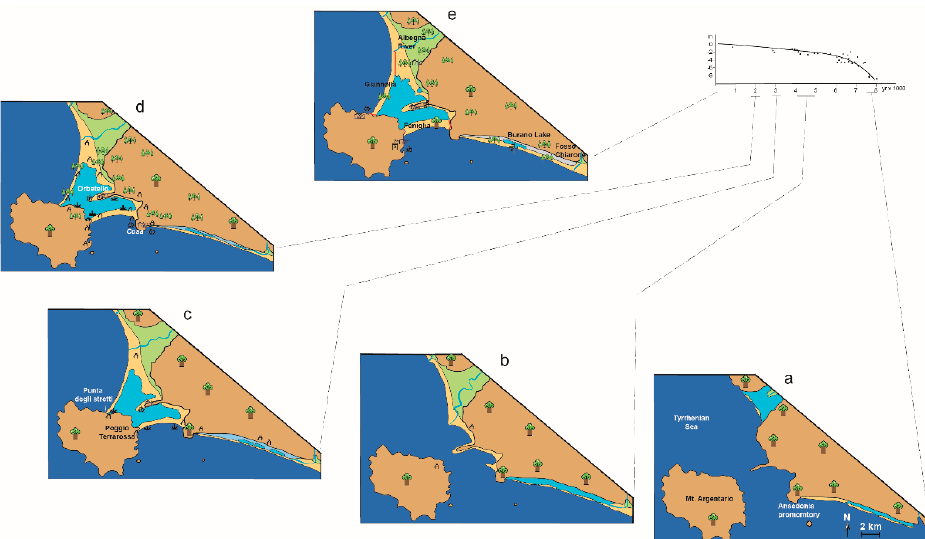
Figure 4. ( a – e ). Two-dimensional evolutionary patterns of the Tuscany area inferred from under- ground and historical/archaeological data. The single images illustrate the coastal landscape relating to the period shown on the abscissae of the sea level rise curve. The curve was plotted based on 14 C dating from Burano paleolagoon peat levels.